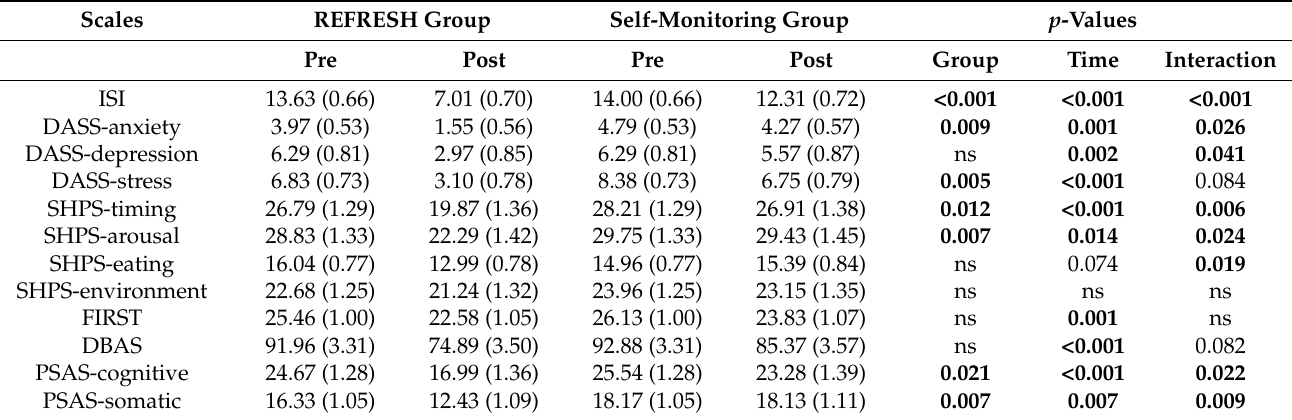
Table 1. Outcome measures in each